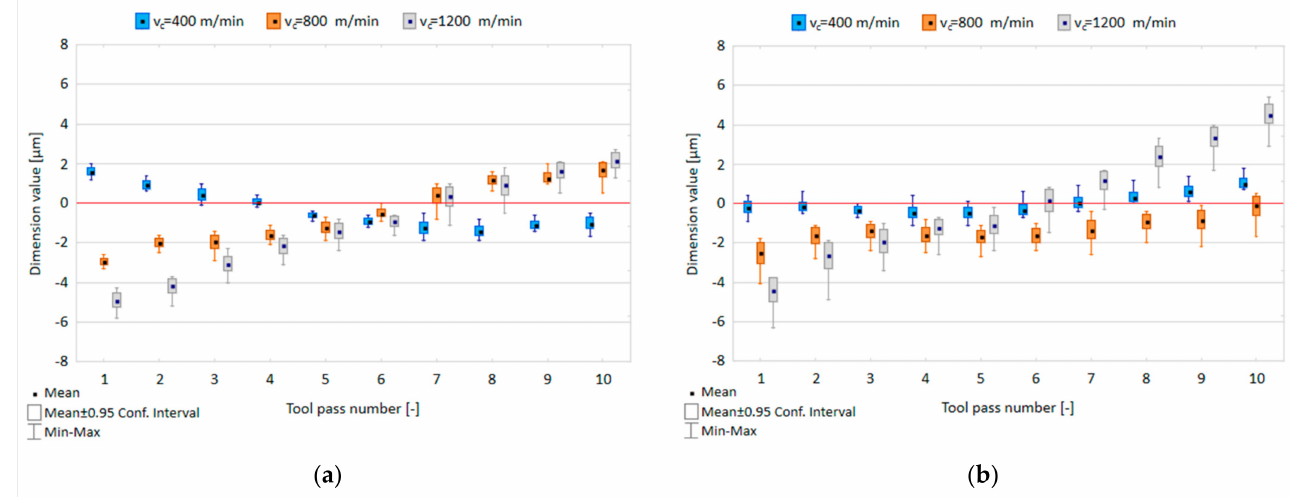
Figure 4. Cutting speed v c versus dimensional accuracy in the milling process performed using a tool coated with: ( a ) TiB 2 and ( b ) TiAlN; (f z = 5 µ m/tooth; a p = 80 µ